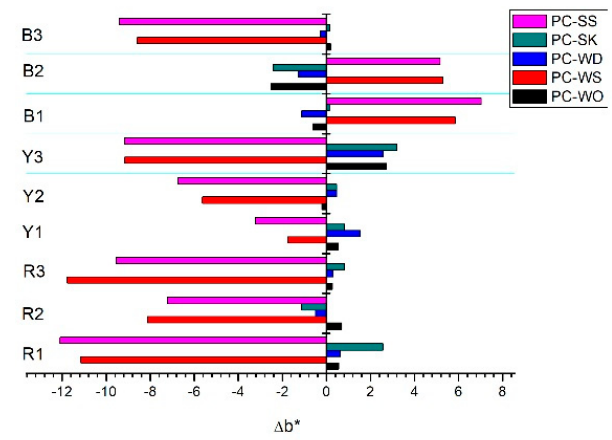
Figure 7. ∆ b* calculated using PC adjustment as the target and the other procedures as Figure 7. Δ b* calculated using PC adjustment as the target and the other procedures as samples.